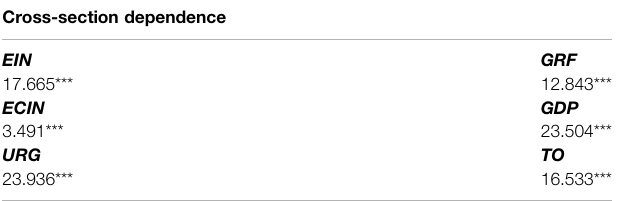
TABLE 4 | Cross-section dependence.